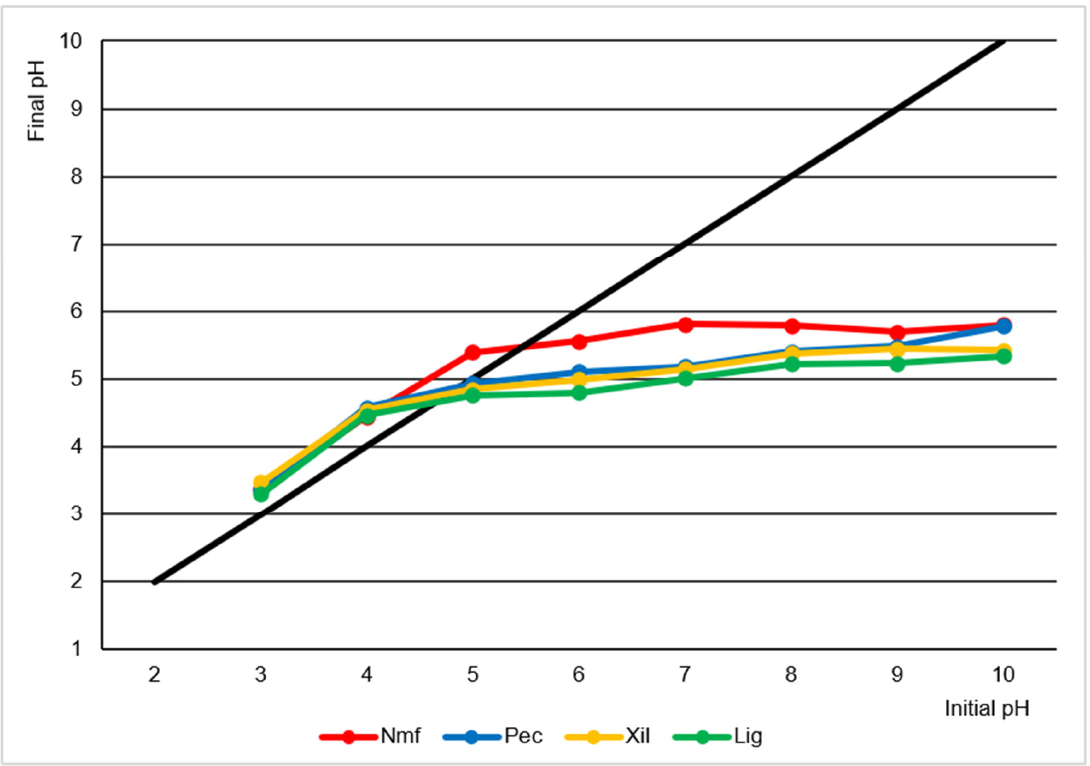
Figure 4. Point of zero charge for the fique fiber before and after modification: NMF: nonmodified fiber, Pec: fiber treated with pectinase, Xyl: fiber treated with xylanase, Lig: fiber treated with ligninase.